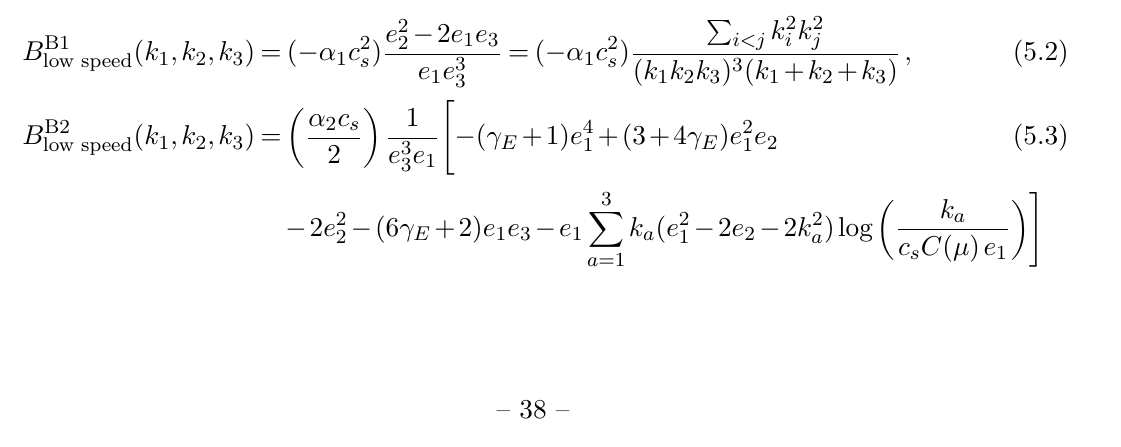
1 . Right : The same quantities for s m/H (cid:28) and heavier (in this case s